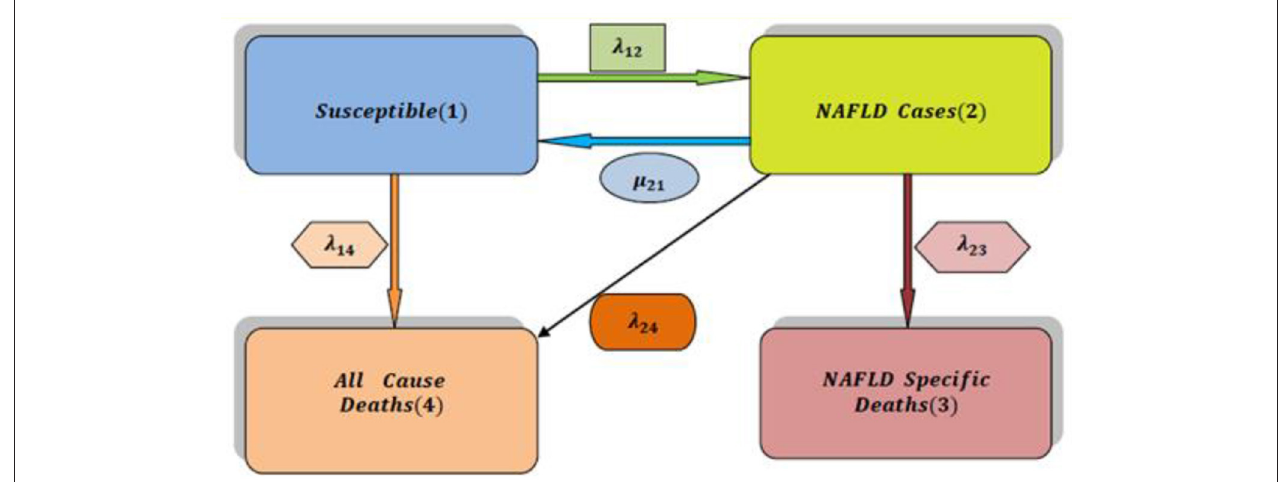
FIGURE 1 | The simplest multistate model for analysis of NAFLD (health-illness-death process)